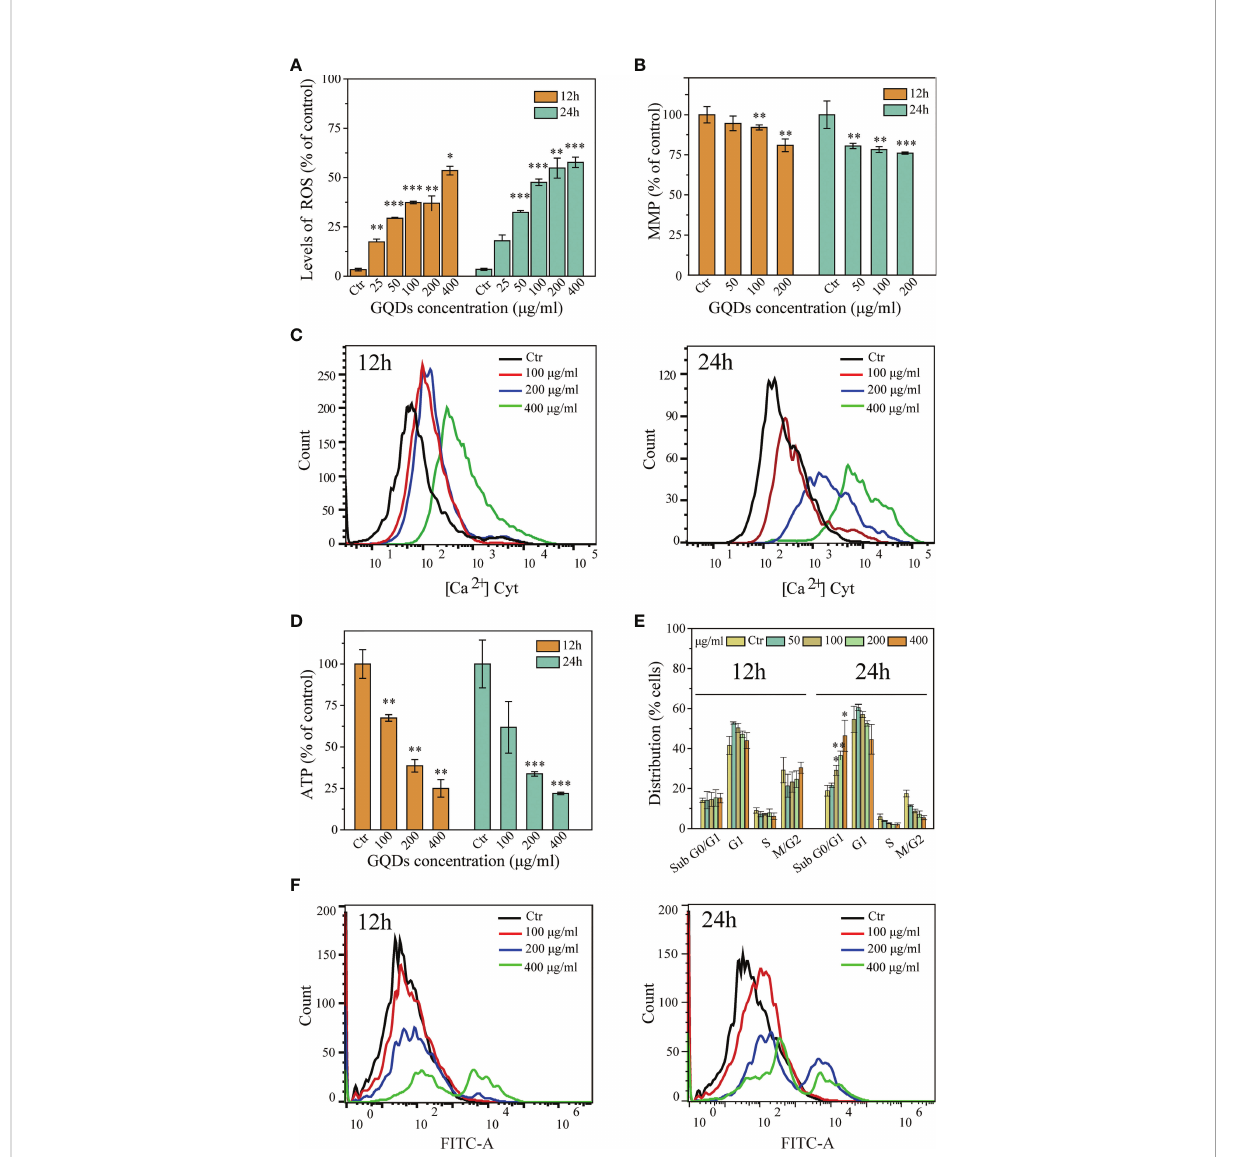
FIGURE 3 Cytotoxicological effects graphene quantum dots (GQDs) on Trypanosoma brucei 12 and 24 h post-exposure. (A) Quantitative analysis of T. brucei intracellular reactive oxygen species (ROS) values based on the results in Supplementary Figure S7. The intracellular ROS levels increased with prolonged exposure and increased doses. (B) Alterations of the MMP ( D Y m ) in T. brucei following treatment with GQDs. The levels of D Y m decreased with increased doses and duration of exposure. A JC-10 fl uorescent probe was applied for the detection using fl ow cytometry (Supplementary Figure S8). (C) Increased cytoplasmic Ca 2+ concentration of T. brucei following treatment with GQDs for 12 and 24 h, demonstrated by fl ow cytometry. Changes in the intracytoplasmic Ca 2+ concentration captured by confocal microscopy, which can be seen in Supplementary Figure S9. (D) Intracellular ATP was signi fi cantly decreased in T. brucei after exposure to GQDs. (E) Exposure to GQDs resulted in the developmental arrest of T. brucei. The proportions of cell cycle dispersion are shown in graphs, predicated in the fl ow cytometry data in Supplementary Figure S10. (F) Flow cytometry analysis of the increased DNA fragmentation in T. brucei after treatment with varying concentrations of GQDs for 12 and 24 h using TUNEL (terminal deoxynucleotidyl transferase dUTP nick-end labeling) staining. T. brucei parasites that were not exposed to GQDs served controls. All values are the mean ± SD of triplicates. Student ’ s t -test was used to obtain p - values. * p < 0.05, ** p < 0.01, *** p < 0.001 (compared to the